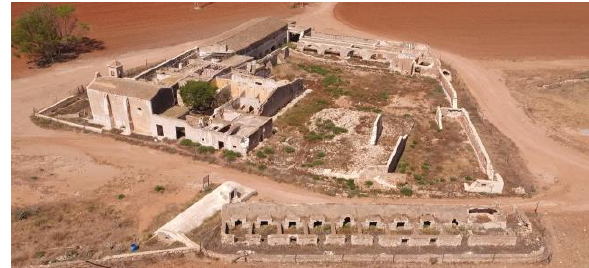
Fig. 3. Current state of ruin of the facilities of Cortijo del Fraile